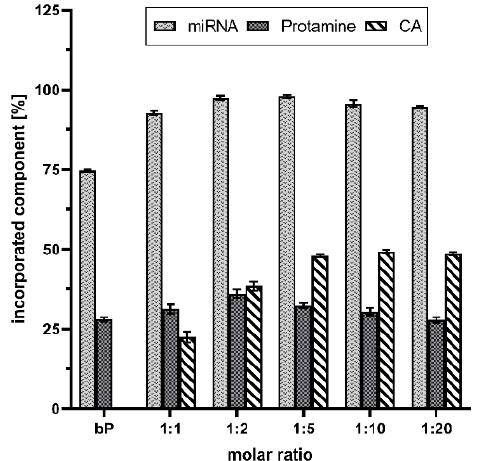
Figure 1. microRNA (miRNA) loading, as well as quantification of administered excipients of citric acid (CA), supplemented proticles, and binary proticles (bP). Data are presented as mean values ( n = 3) ± standard deviation. The results were obtained by indirect quantification, measuring the supernatants of the nanoparticle dispersions after centrifugation, and calculating the difference between the applied amount and the detected amount as a percentage. The molar ratio refers to a molar protamine:CA ratio.